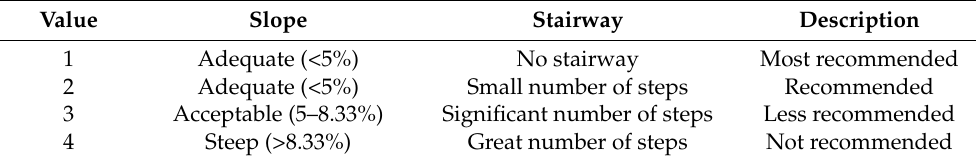
Table 13. Parameters for the Index of Slopes and Stairs (‘is’) within the study area. Value Slope Stairway Description 1 Adequate (<5%) No stairway Most recommended 2 Adequate (<5%) Small number of steps Recommended 3 Acceptable (5–8.33%) Significant number of steps Less recommended 4 Steep (>8.33%) Great number of steps